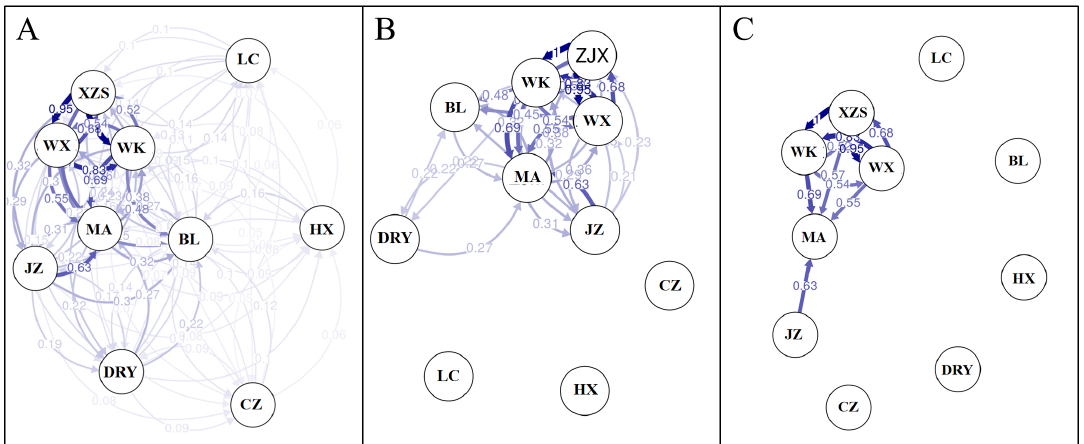
Figure 6. Directional relative migration networks of the studied carp populations constructed with divMigrate. Numbers on the arrows represent the relative migration coefficients derived from F ST statistics. Line shading and thickness increase with the relative strength of gene flows. When larger than 0.05 ( A ), 0.2 ( B ), or 0.5 ( C ), the coefficients are displayed.